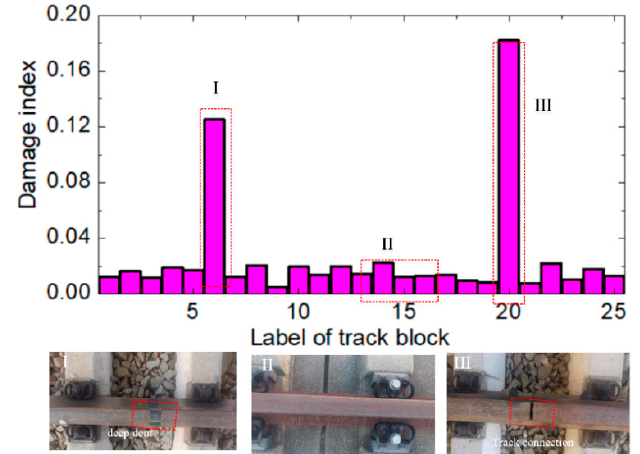
Figure 16. Damage index values of the rail structure based on WSNs embedded with SMFS.